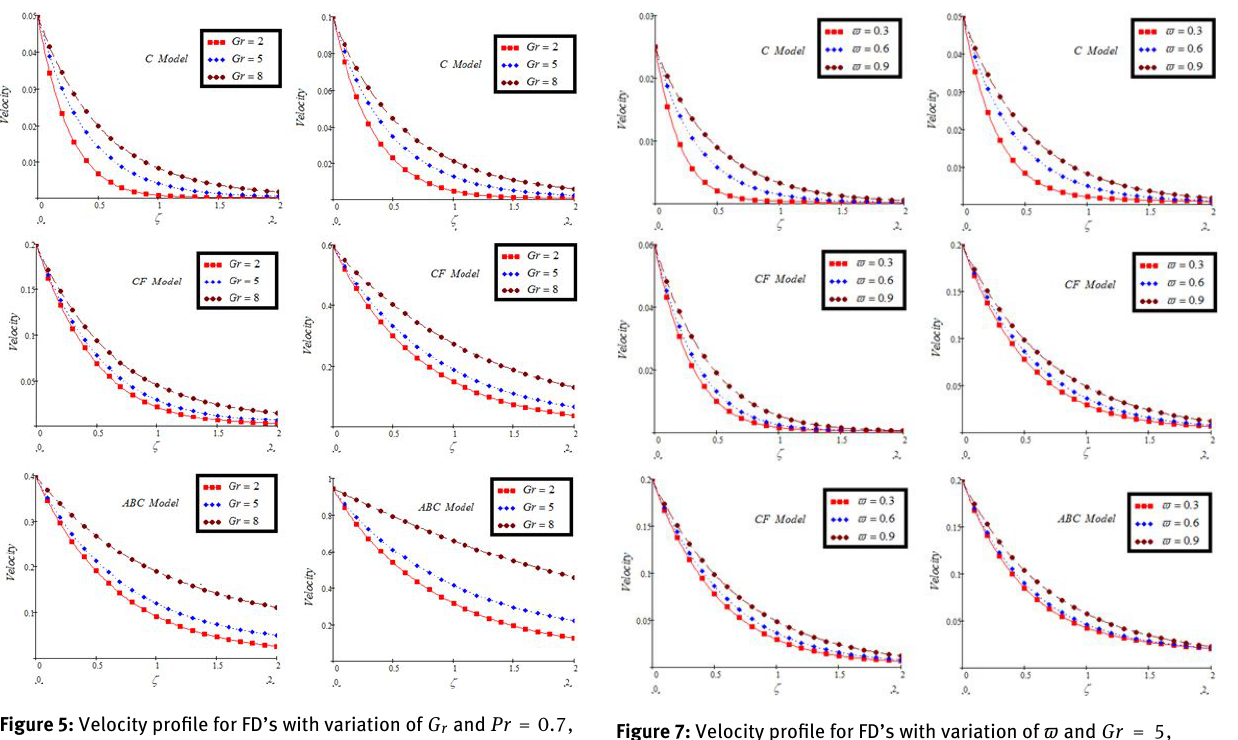
Figure 6: Velocity profile for FD’s with variation of Gm and Pr = 0.7, (cid:61) = 0.8, ε = 0.6